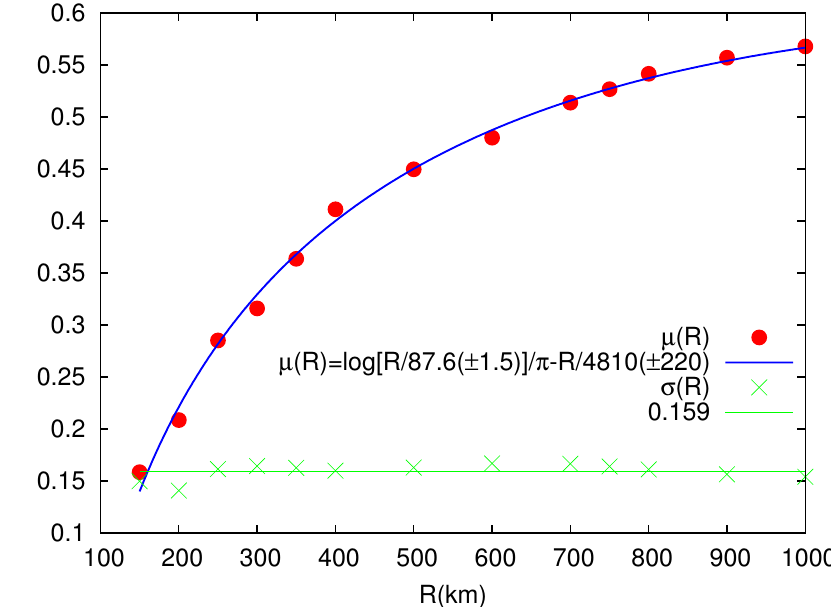
Figure 7. The average value µ ( R ) (red bullets) together with the standard deviation σ ( R ) (green crosses) of the (cid:104) EPS (cid:105) values closest to each epicenter of the six M ≥ 8.5 EQs (see Table 2 and Figure 5) versus the coarse grain radius R . The expressions for the fitting function µ ( R ) (blue) and the average value of σ ( R ) (green horizontal line) are also